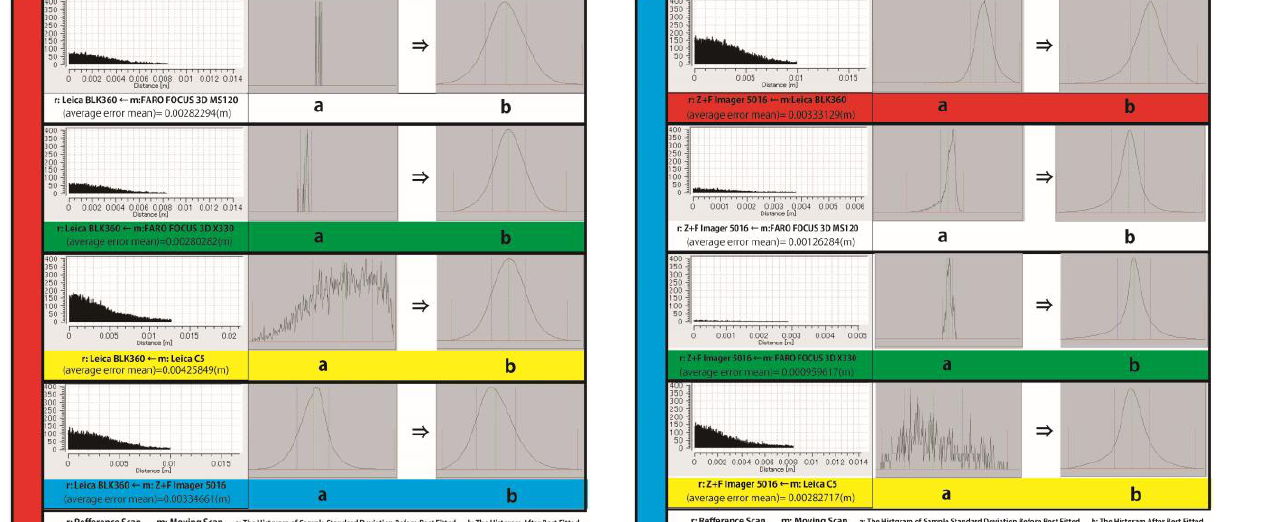
Figure 14: The Results of Aligning (Refference:Z+F Imager 5016), (3D Recnstructor and IMAlign were used)